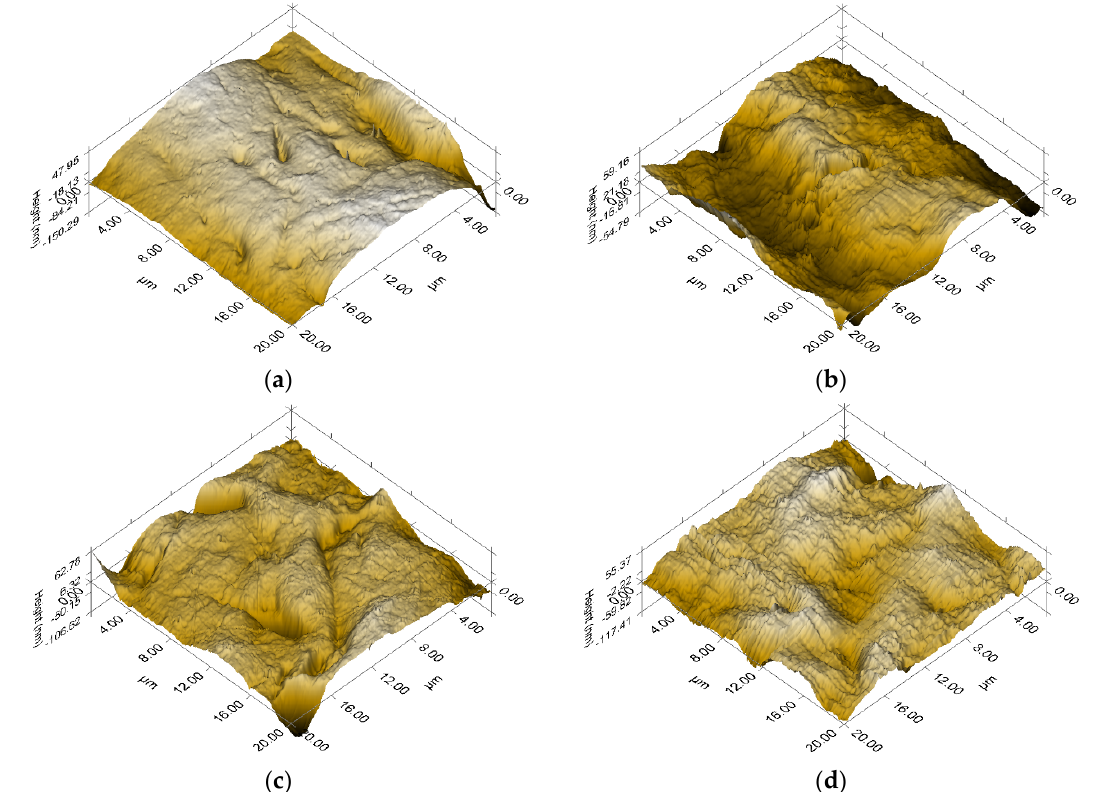
Figure 10. Topography SPM for the Pd 80 Rh 20 alloy before and after hydrogen electrosorption: ( a )